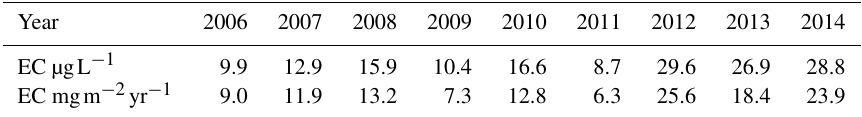
Figure 4. EC concentrations (µgL − 1 ) in the Holtedahlfonna stake 10 snow pit and firn core, and EC deposition (mgm − 2 yr − 1 ). (a) EC concentrations of the snow pit against the snow depth. In addition, the April 2015 and approximate September 2014 layers are indicated. (b) EC concentrations in the firn core (solid line), snow pit (dashed line, same as a ) and previous surface snow samples (blue stars) with depth and year. The previous surface snow measurements are by Forsström et al. (2013). Panels (c) and (d) compare the temporal EC concentrations (c) and deposition (d) in the firn core. The red dots and error bars in panel (c) indicate average EC concentration and the absolute errors of samples from which multiple analyses were performed. Table 1. Annual mean firn core EC concentration and deposition at Holtedahlfonna, stake 10, from 2006 to 2014. The values present total EC concentrations and deposition averaged over the respective year, assuming that the EC deposition rate has stayed constant throughout the respective year. Dating uncertainties of the firn core increase the uncertainties of these